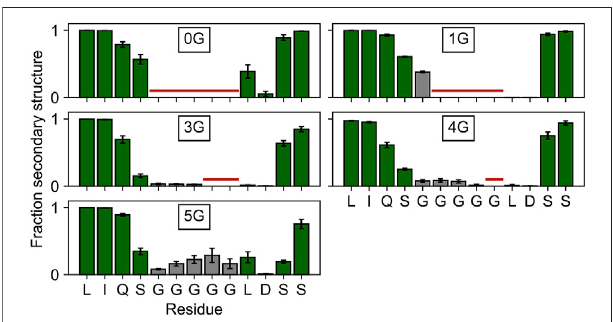
FIGURE3| Secondarystructurecontentinandaroundtheinsertionsite. The secondary structure content of the four residues adjacent to the insertion site is depicted with green bars, that of the glycine insertions with gray bars. Residuesnotpresentinthewildtypeoraparticularconstructaremarked with a horizontal red line. Any β -strand or helix – but no turns or bends – were counted as secondary structure elements.